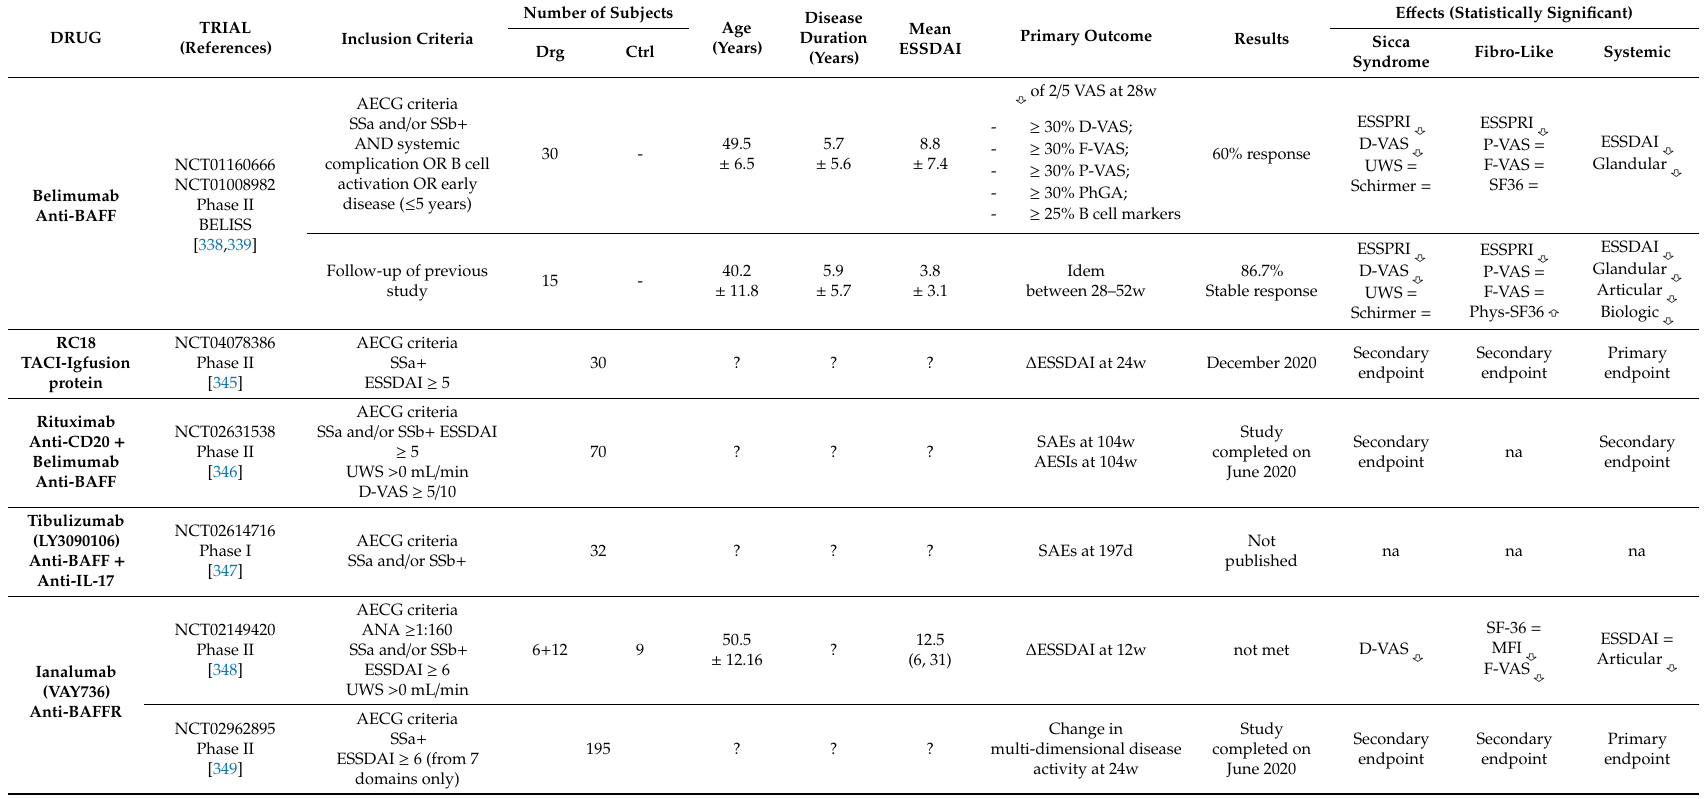
Table 7. B cell targeted drugs in pSS part 2: BAFF / APRIL system targeted